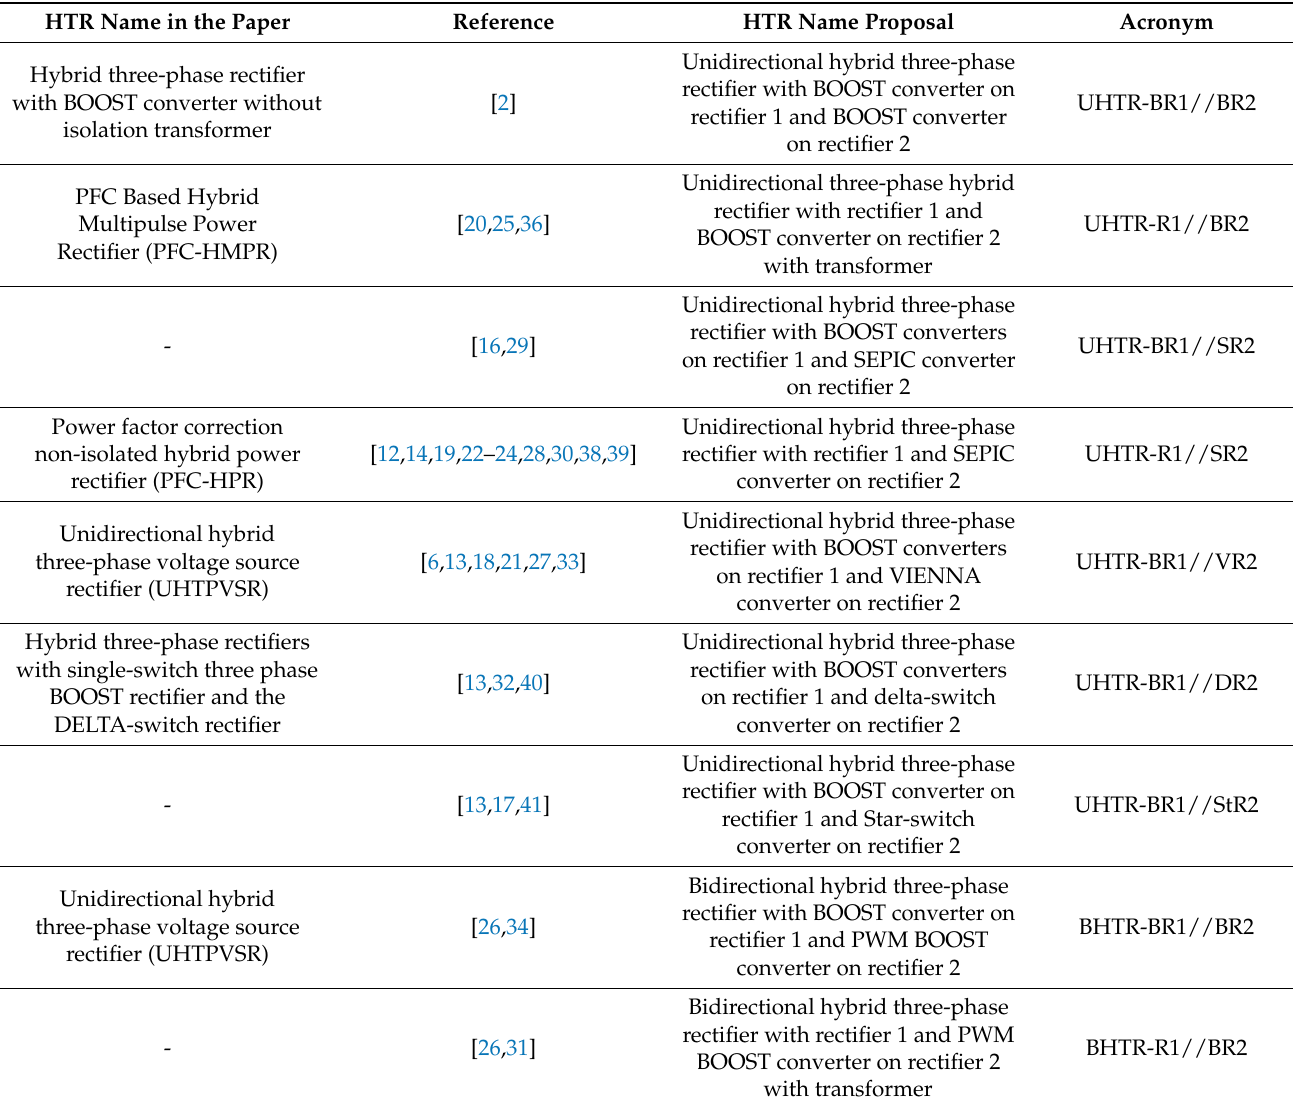
Table 5. HTR classification